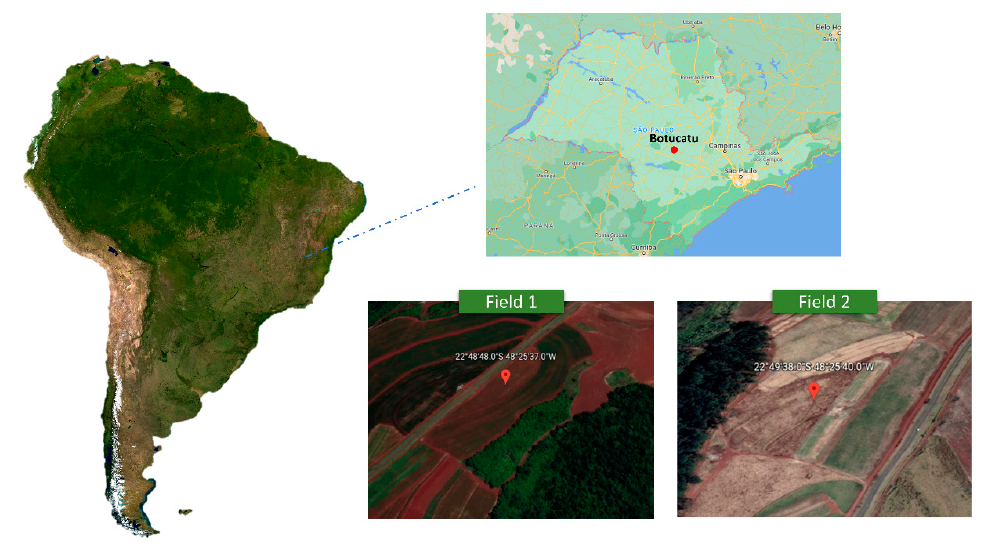
Figure 1. Study area map of both field trial replications.